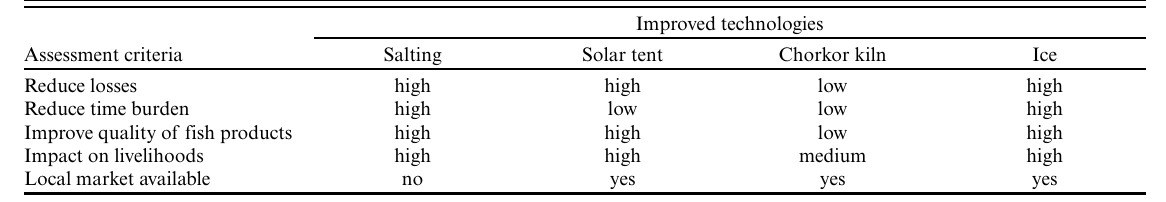
Table 1 . An evaluation of improved postharvest fish processing technologies in the Barotse Floodplain